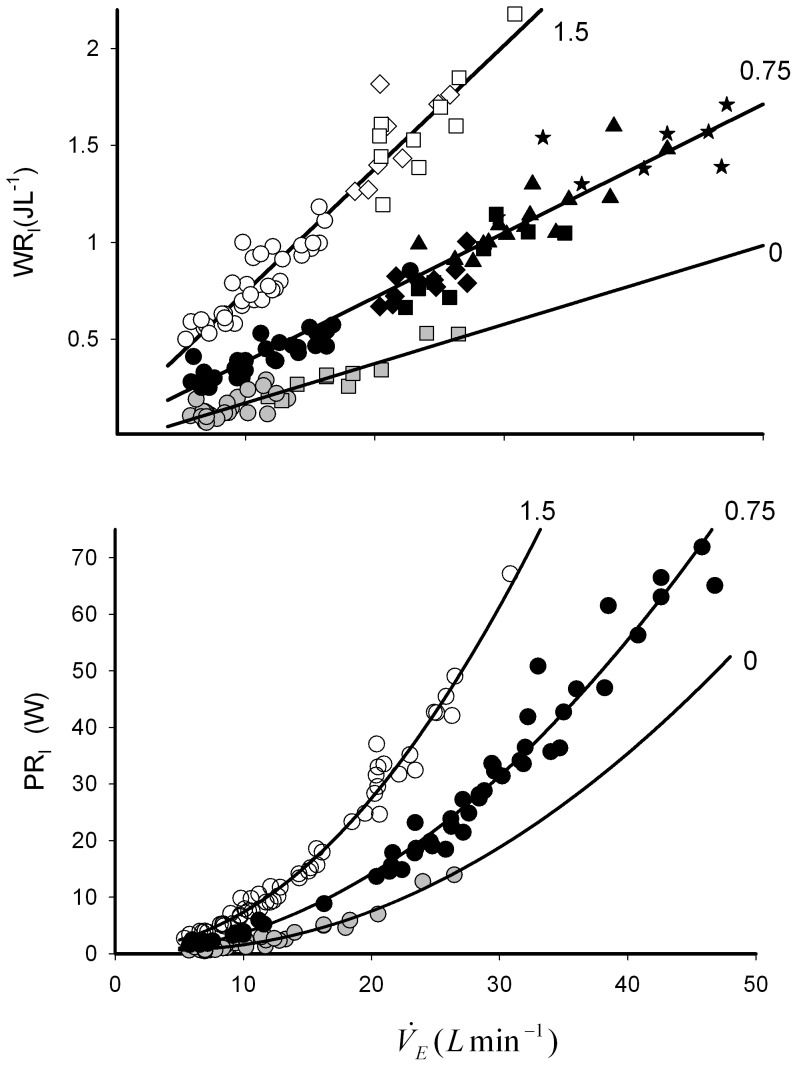
Relationship between ventilation () and the inspiratory work to overcome resistance at the mouth (WRI) (Upper panel) and the associated inspiratory power (PRI) (lower panel) with increasing resistive load (RK).For sake of clarity exercise mode has been omitted on the lower panel (see text) The applied loads were 0 (grey fill), 0.75 (black fill) and 1.5 (no fill) kPa.L.sec−1. In the upper panel, exercise modes; ○, resting and seated; □, walking at 4 kmh−1; ◊, cycling at 50 watts; Δ, cycling at 100 watts; ★stars, cycling at 150 watts. Fitted linear regression are shown for each applied load, R2 = 0.85, 0.93, 0.93, and P2 = 0.83,0.93, 0.92 at 0, 0.75, 1.5 kPa.L.sec−1respectively. In the lower panel no distinction is made between exercise mode and fitted quadratic lines are shown for each applied load, at 0, Y = 0.98+−0.2×+0.03×2, R2 = 0.97 P2 = 0.996, at 0.75 kPa.L.sec−1, Y = 0.05+0.025×+0.034×2, R2 = 0.97, P2 = 0.97, and at load 1.5 kPa.L.sec−1 Y = 0.94+−0.043×+0.07×2 R2 = 0.98, P2 = 0.98. In all cases p<0.001.